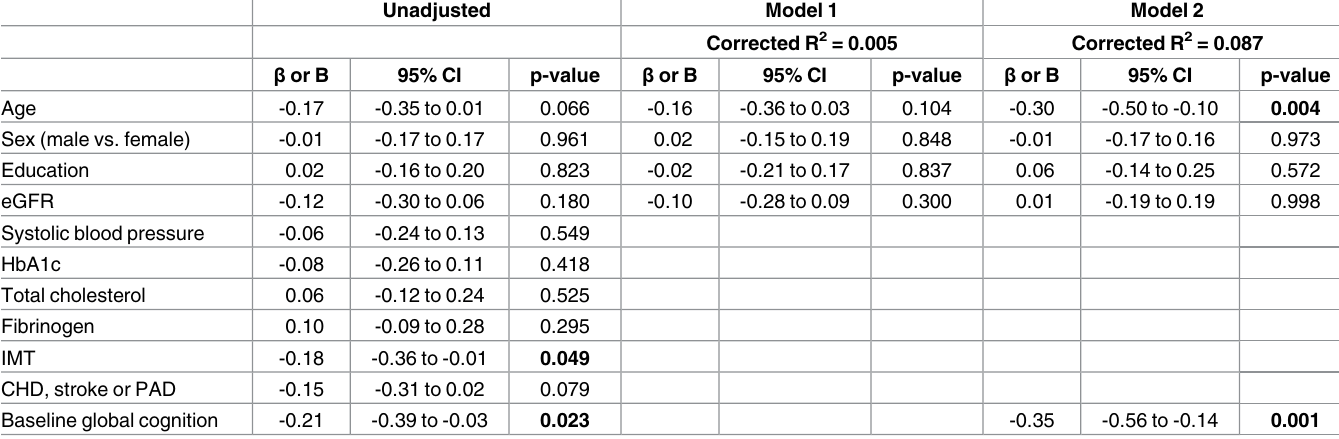
Table 4. Baseline Predictors for Change of Global Cognitive Performancefrom Baseline to Follow-up in the Total Cohort: Unadjusted and Simple Multivariable